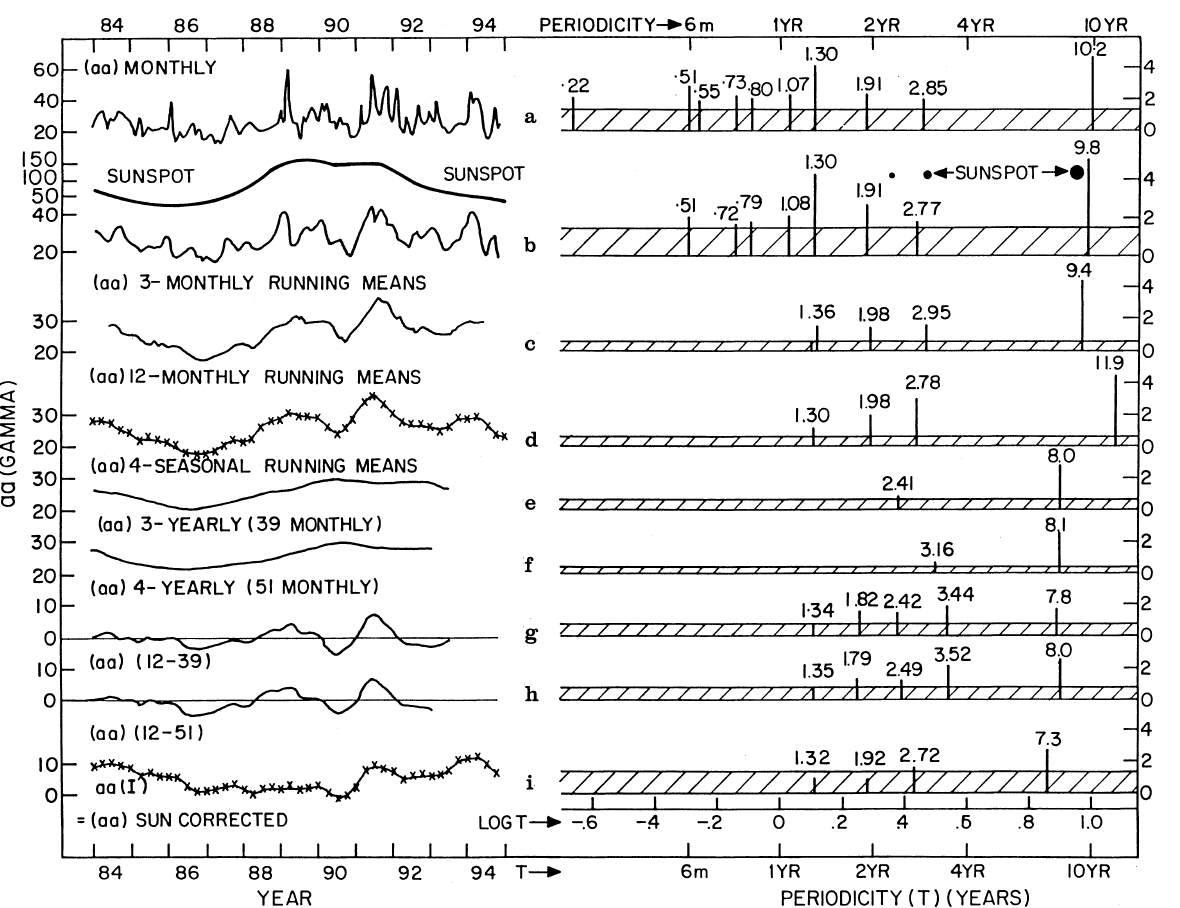
running means (4 values per year); f 4-yearly (51 months) running means (4 values per year); g aa (12–39) i.e., c minus e ; h aa (12-51) i.e., c minus f ; i aa(I) i.e., sunspot-corrected aa. For spectra in the right half , the hatched portion in the 2